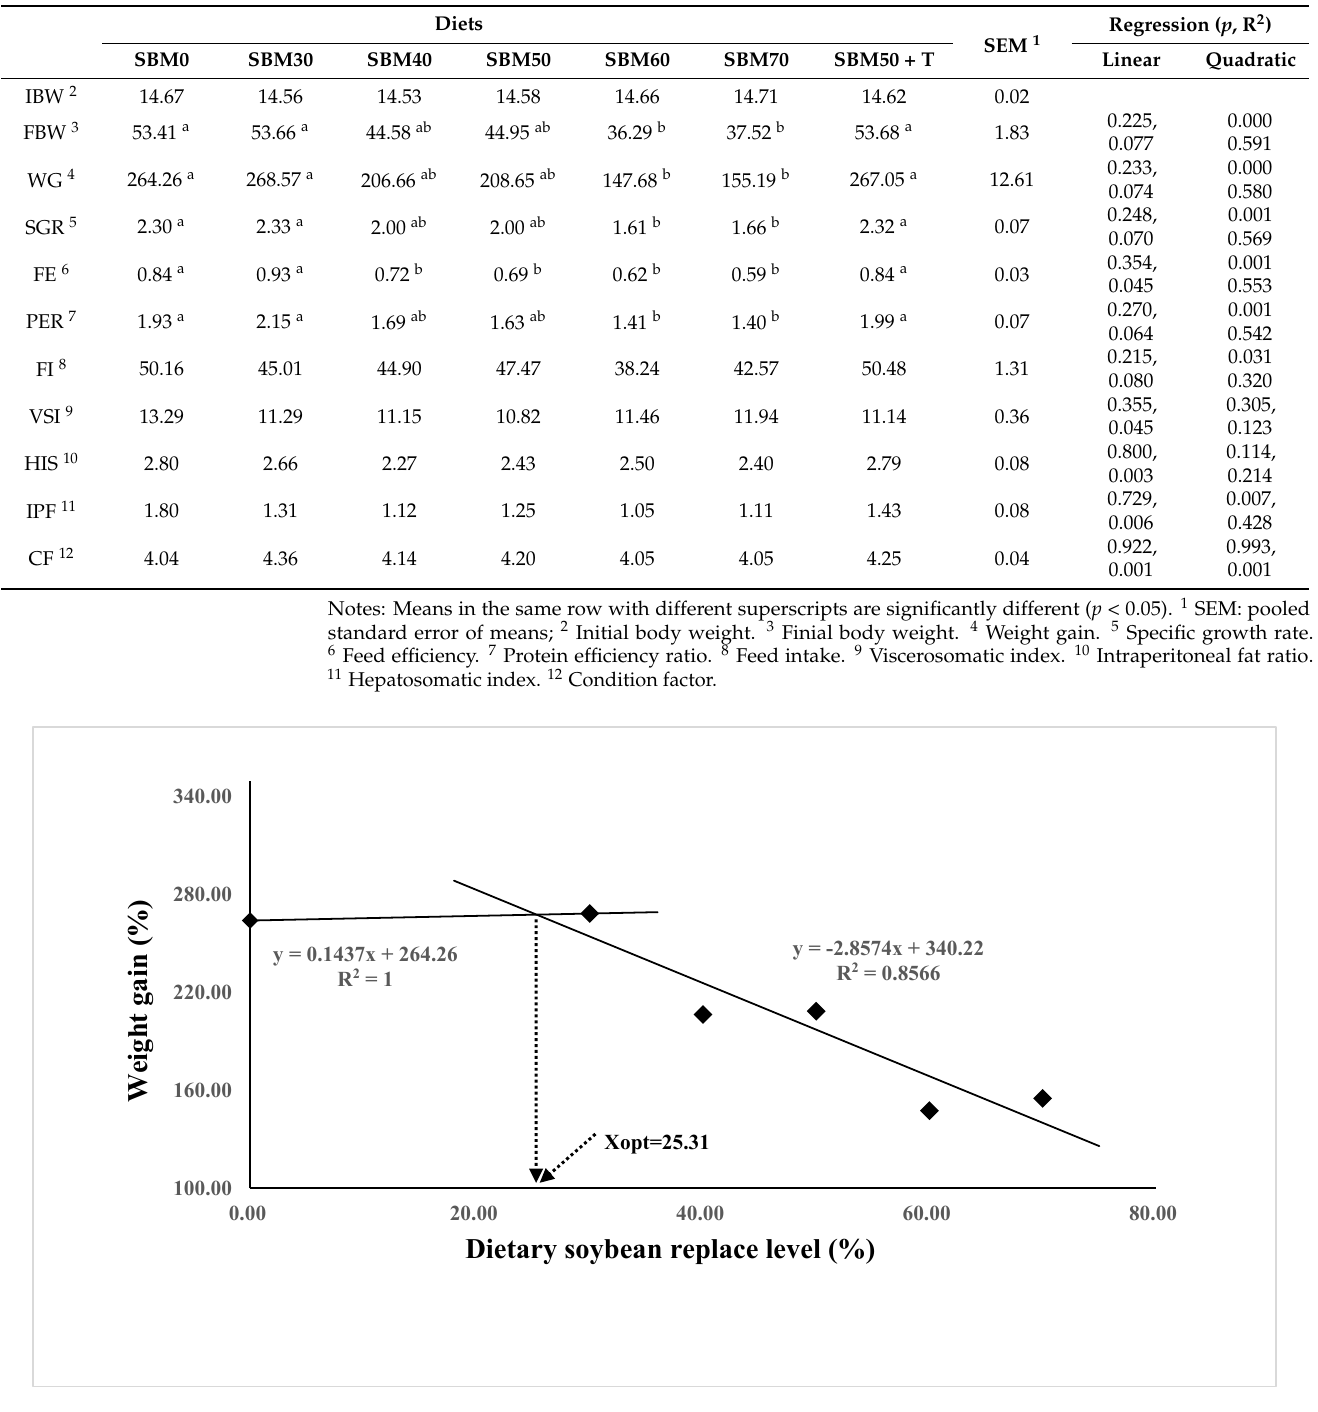
Figure 1. Relationship between the weight gain (WG, %) and the dietary soybean level based on two slope broken-line regression analysis, where Xopt represents the optimal dietary soybean replacement level for the maximum WG.